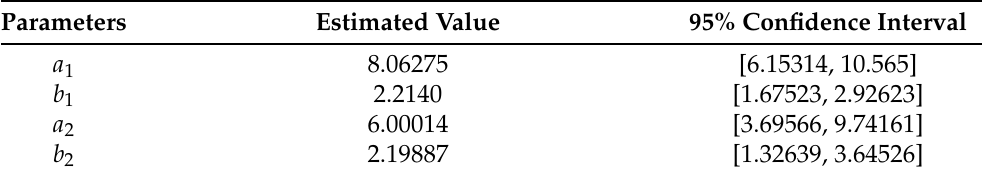
Table 1. Estimated parameter values (gamma